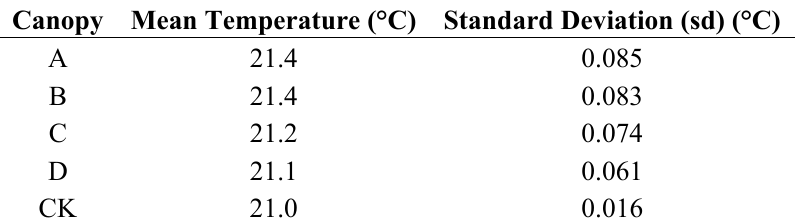
Table 2. Dependence of temperature variability (expressed as the standard deviations) as a function of soil moisture for a range of